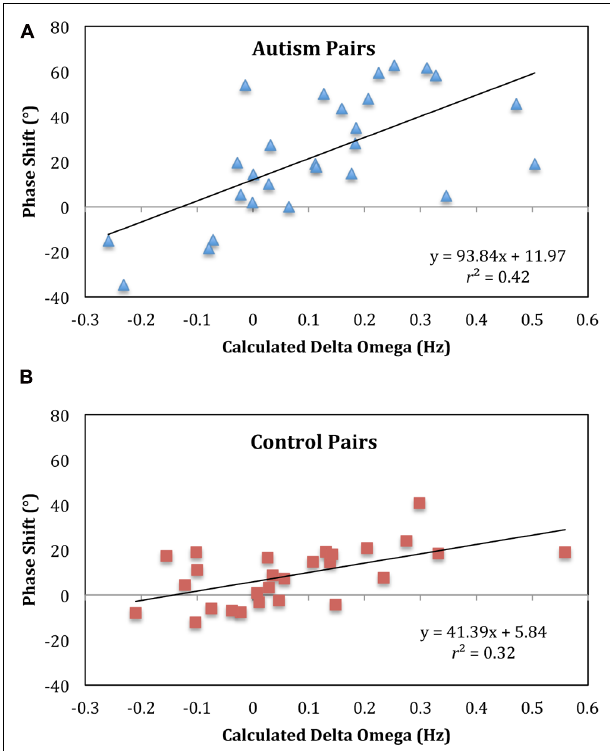
FIGURE 5 | Phase shift regressions indicate weaker coupling for autism pairs. A regression with relative phase angle (phase shit) as the dependent variable and calculated delta omega as the independent variable revealed that for both the pairs with autism (A) and controls (B) with autism and controls the slope and intercept were significantly different from 0. The intercepts were not significantly different between groups but the slopes were. The pairs with autism have a steeper slope, indicative of weaker interpersonal